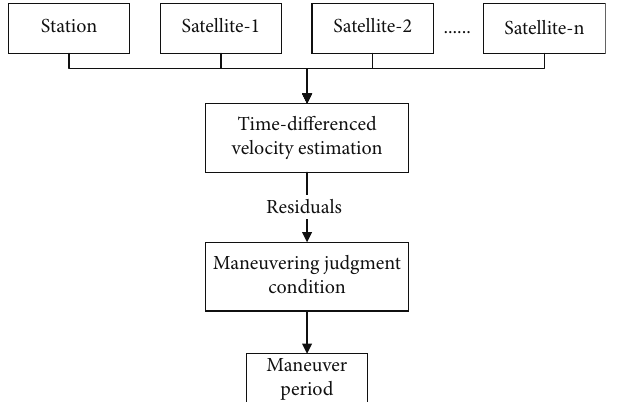
Figure 3: Flow chart of detection of maneuvering